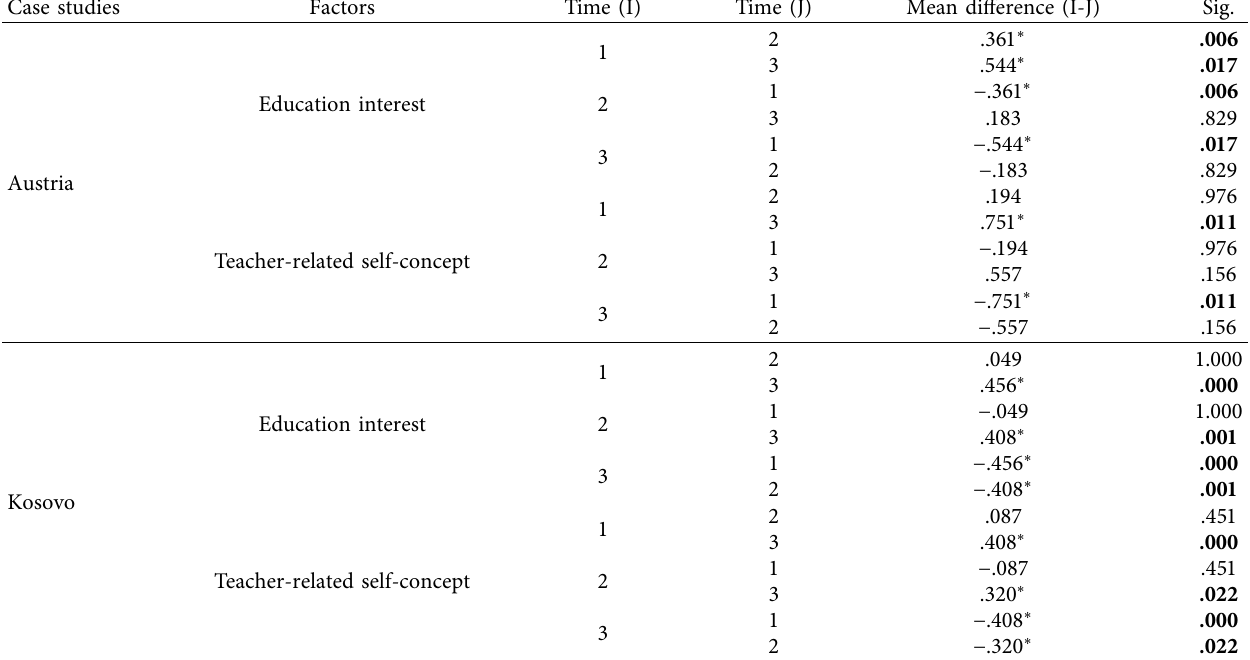
Table 9: Pairwise